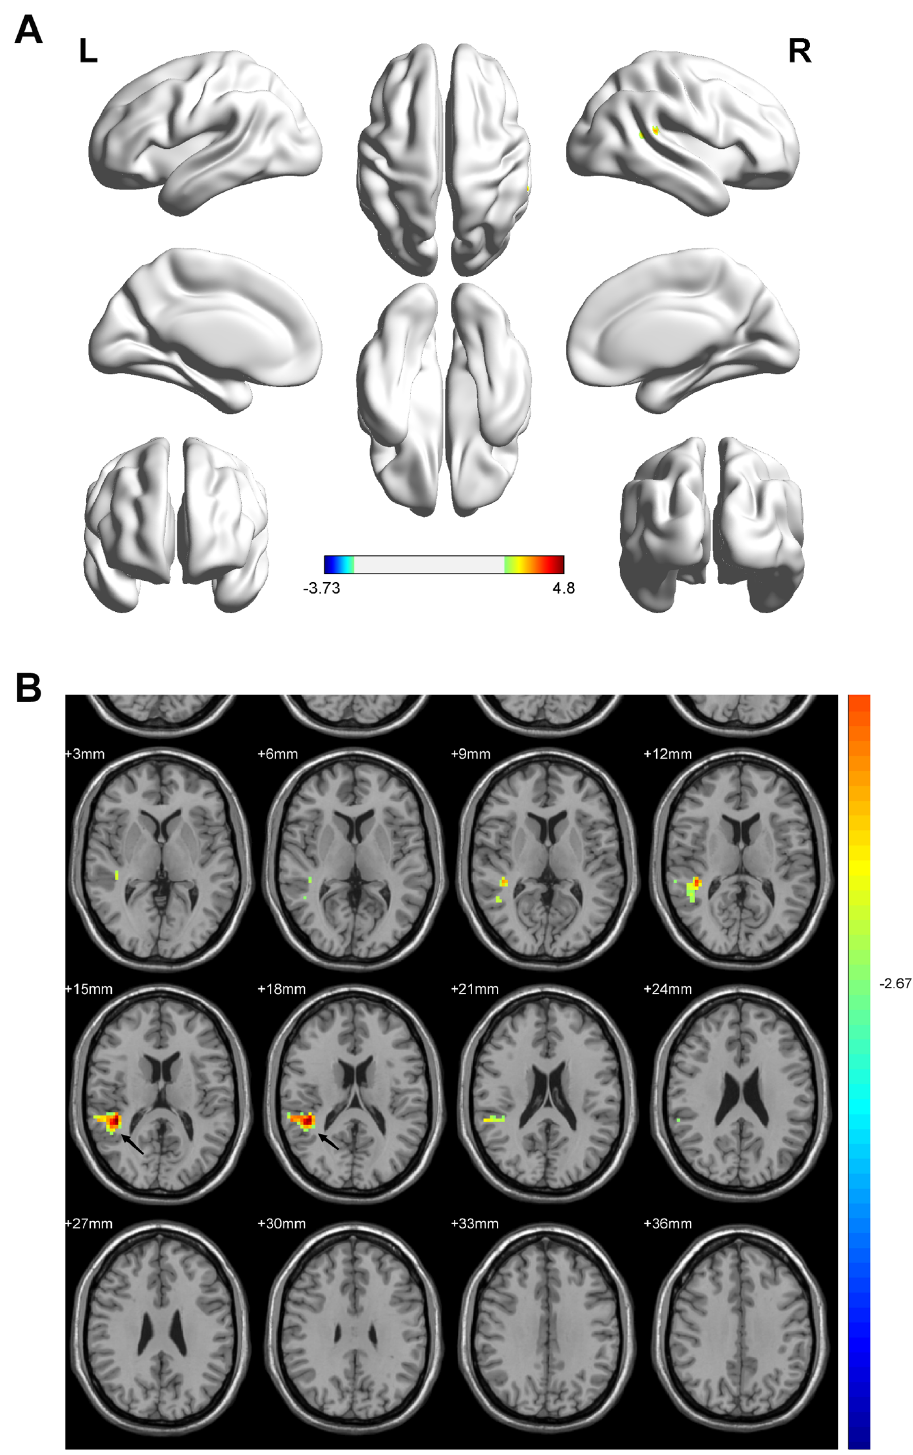
Fig 2. Comparison of regional brain activation measures by ALFF. The results are shown in a 3D view in A and a 2D view in B. Average activation maps for the fMRI under analgesia for breastmilk-fed and formula-fed infants. The threshold was set at p < 0.01 after the Bonferroni correction given a cluster size � 40 voxels. All images are displayed in the radiologic convention (left/right flipped). Breastmilk-fed infants had more extensive activation in the right temporal lobe (black arrow). The regions are highlighted in yellow/green (breastmilk-fed > formula-fed).